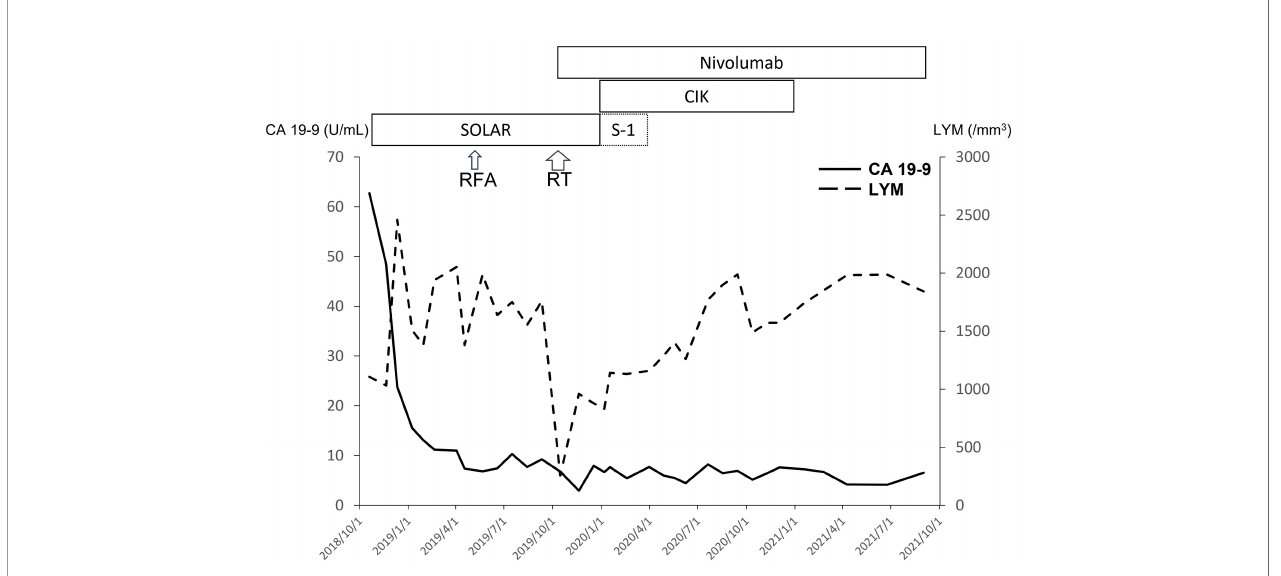
FIGURE 2 | With extreme response to the SOLAR regimen, the level of CA 19-9 decreased rapidly. The lymphocyte count (LYM) decreased after chemotherapy and RT initially but recovered with maintenance nivolumab ± CIK cell